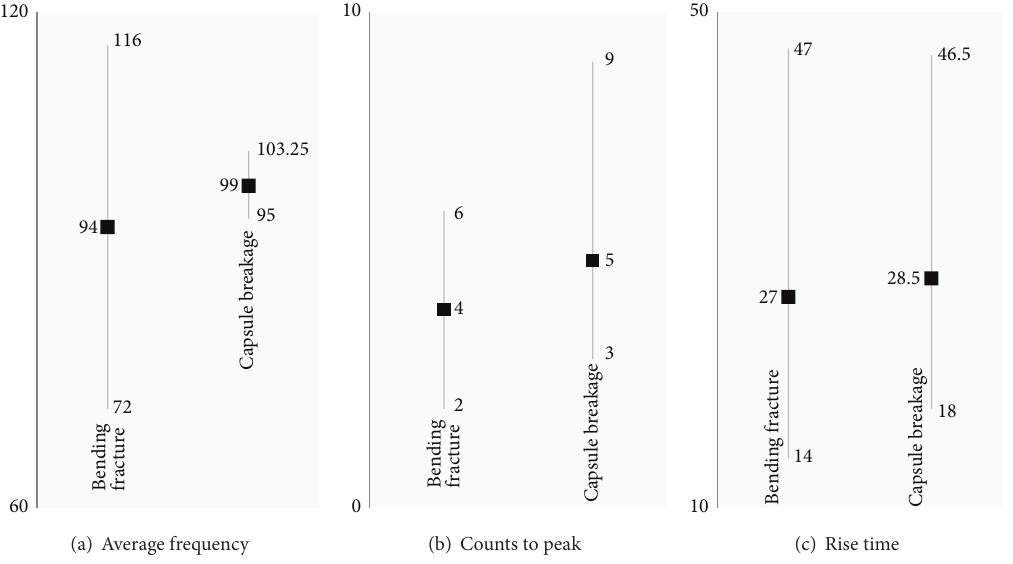
Figure 17: Clustering of AE features-part